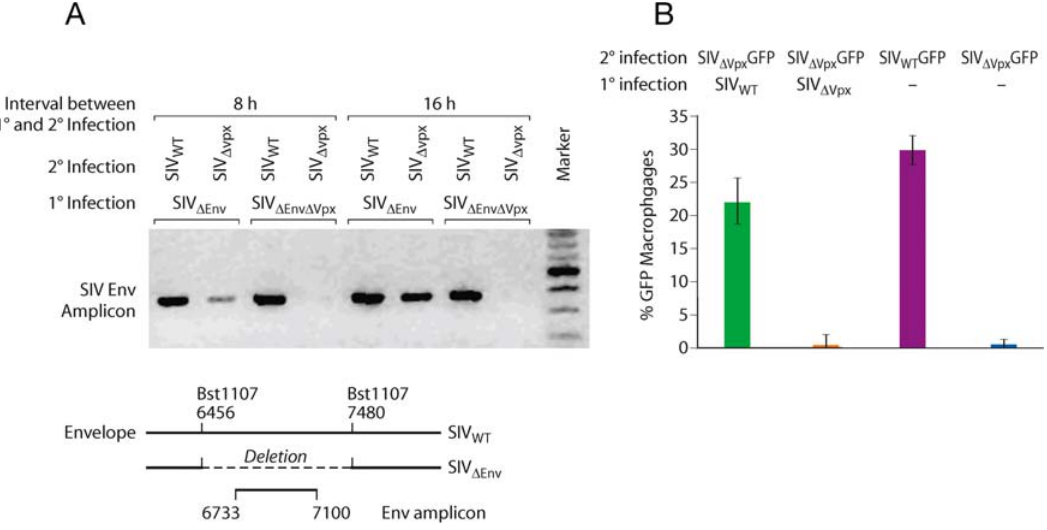
Figure 2. Vpx delivered to macrophages by SIV WT infection removes a block to subsequent infection by SIV D vpx . (A) Macrophages were initially infected (1 u infection) with envelope deleted SIV variants harboring intact or defective Vpx genes. The nature of the envelope deletion is shown in the lower panel. Those cells were then super-infected (2 u infection) with SIV WT or SIV D vpx variants harboring intact envelope genes. cDNA products resulting from the super infection were then specifically amplified using envelope-specific primers. (B) Similar experiment was performed using SIV WT or SIV D vpx for 1 u infection and SIV WT or SIV D vpx GFP variants for 2 u infection. Number of GFP-positive cells was determined 24 hr post 2 u infection (error bars are s.d., n=3).